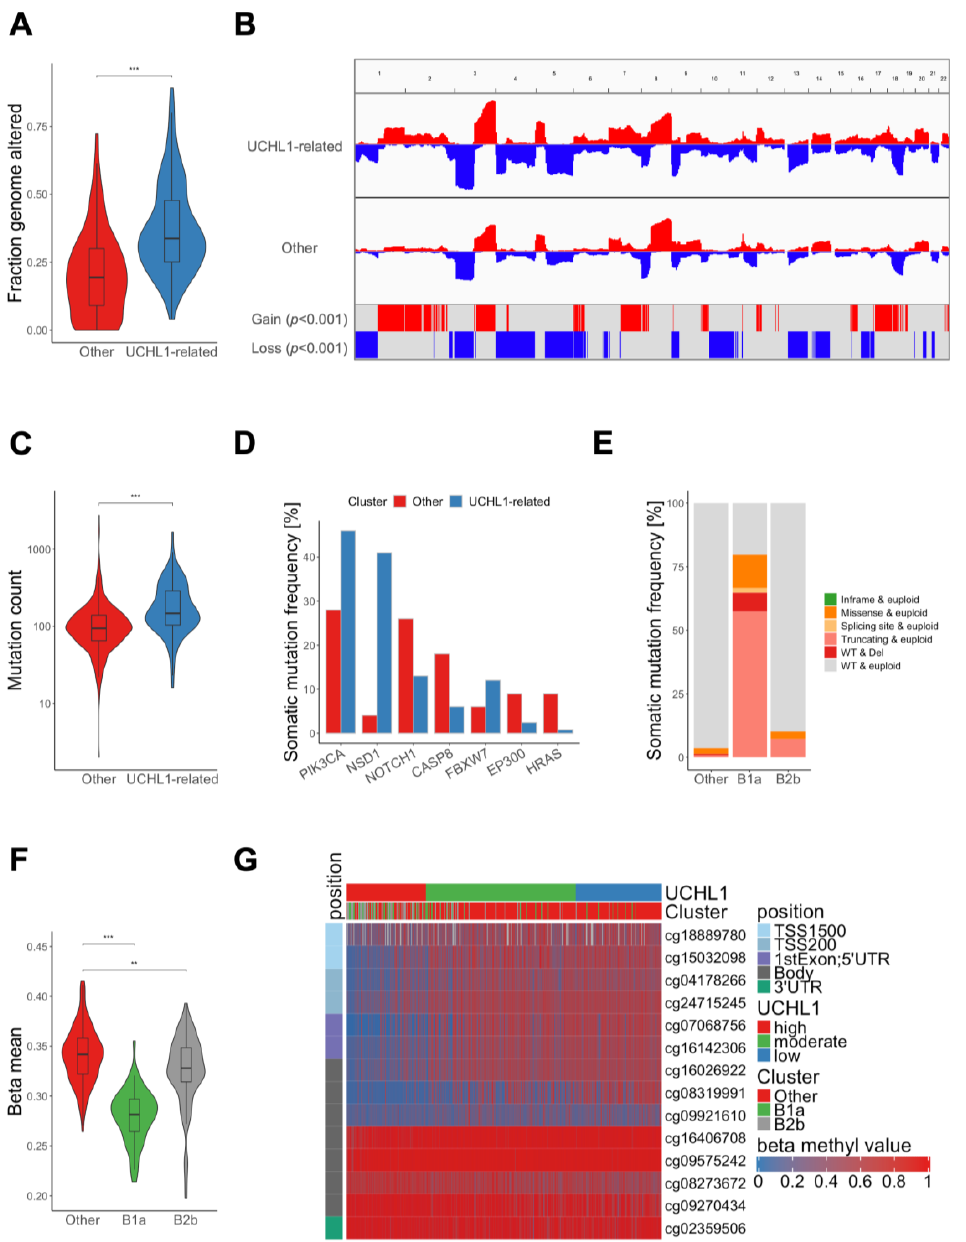
Figure 2. Molecular characterization of UCHL1-related tumors from TCGA-HNSC. ( A ) Violin plot shows a significant difference in the fraction of altered genome between UCHL1-related (blue) and other tumors (red). ( B ) CNV plot illustrates relative frequencies of copy number gains (red) and losses (blue) for UCHL1-related and other tumors with indicated hot spot regions according to a significance level ( p < 0.001) by a Fisher exact test. ( C ) Violin plot shows a significant difference in somatic mutation counts between UCHL1-related (blue) and other tumors (red). ( D ) Bar plot for MutSig candidate genes with a significant difference ( p < 0.05) in somatic mutation frequency between UCHL1-related (blue) and other tumors (red). ( E ) Bar plot represents quantitative and qualitative differences in somatic NSD1 mutations for HNSC of sub-cluster B1a, B2b and other tumors. ( F ) Violin plot shows significant differences in global DNA methylation (beta mean) between HNSCs of sub-cluster B1a, B2b and other tumors. ( G ) Heatmap based on supervised clustering (UCHL1 transcript value) with DNA methylation values of probes annotated for the UCHL1 gene locus. ** p < 0.005, *** p < 0.0005 based on Wilcoxon rank sum